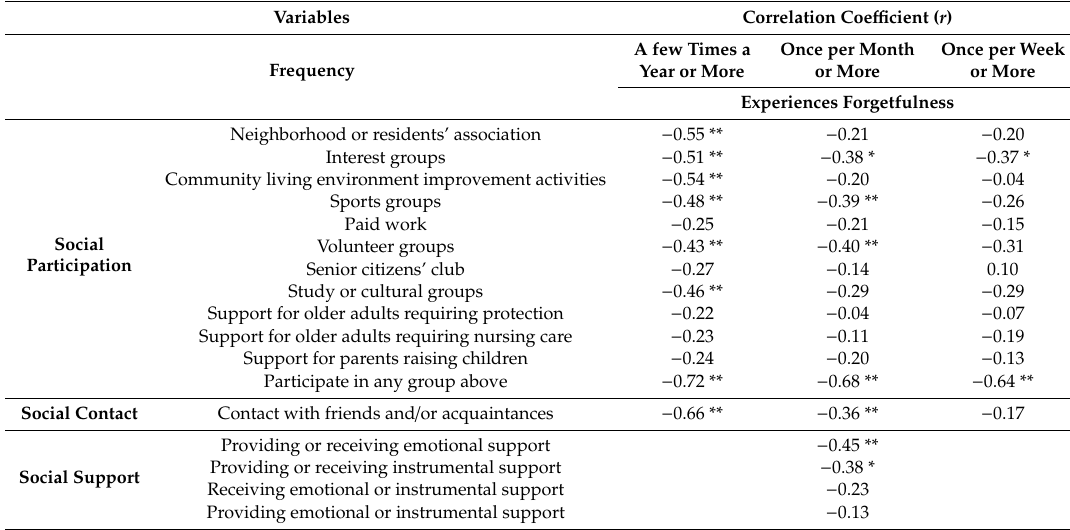
Table 2. Partial correlation analysis between the ratio of people with forgetfulness and social participation by